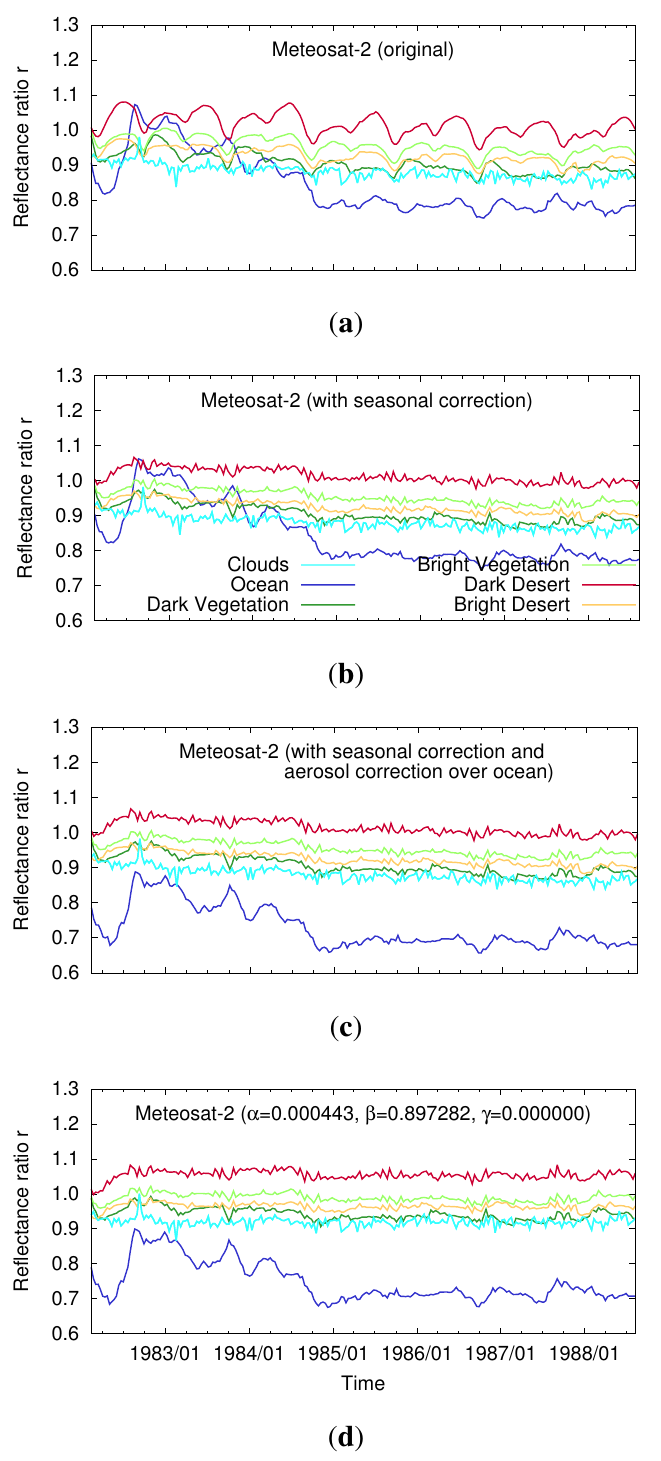
Figure 7. Meteosat-2 time series ( a ) original; ( b ) after seasonal correction; ( c ) after aerosol correction; and ( d ) after ageing